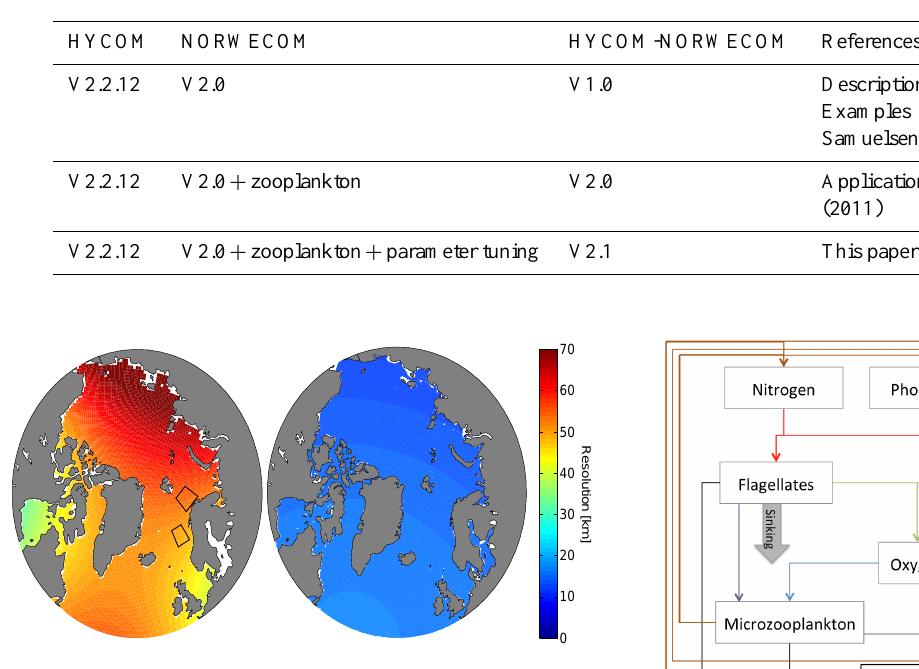
Table 1. Model versions and references.